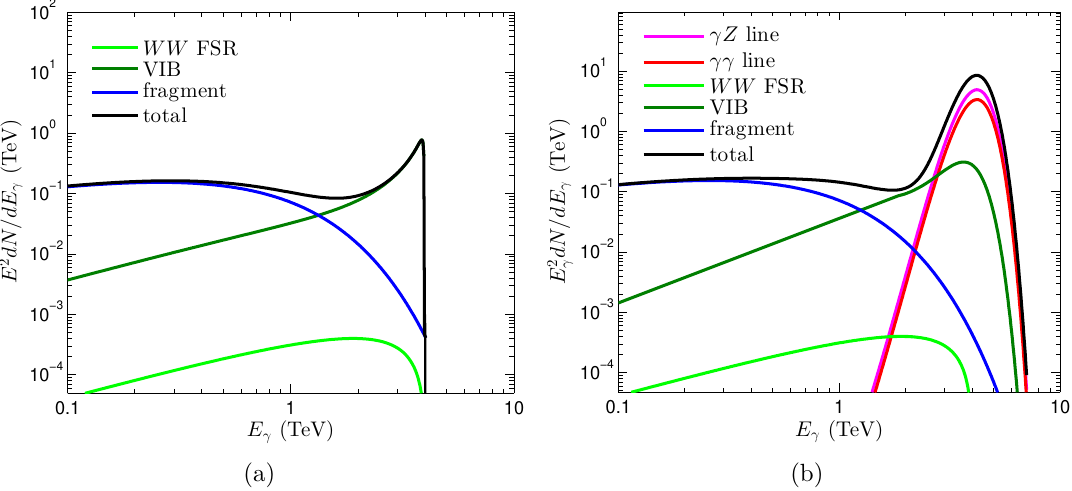
Figure 7. Weighted differential photon multiplicity for complex quartet with freeze-out mass of 4.05 TeV (black). Also shown, contribution from W + W − and ZZ fragmentation (blue), VIB (dark green), W + W − FSR (light green), γγ line (red) and γZ line (magenta). The branching ratios for diboson channels read B = 0 . 05 , B ZZ = 0 . 35 , B γZ = 0 . 45 and B γγ = 0 . 15 . Right panel (7(b)) W + W − depicts the same spectra, as seen by a detector with resolution of